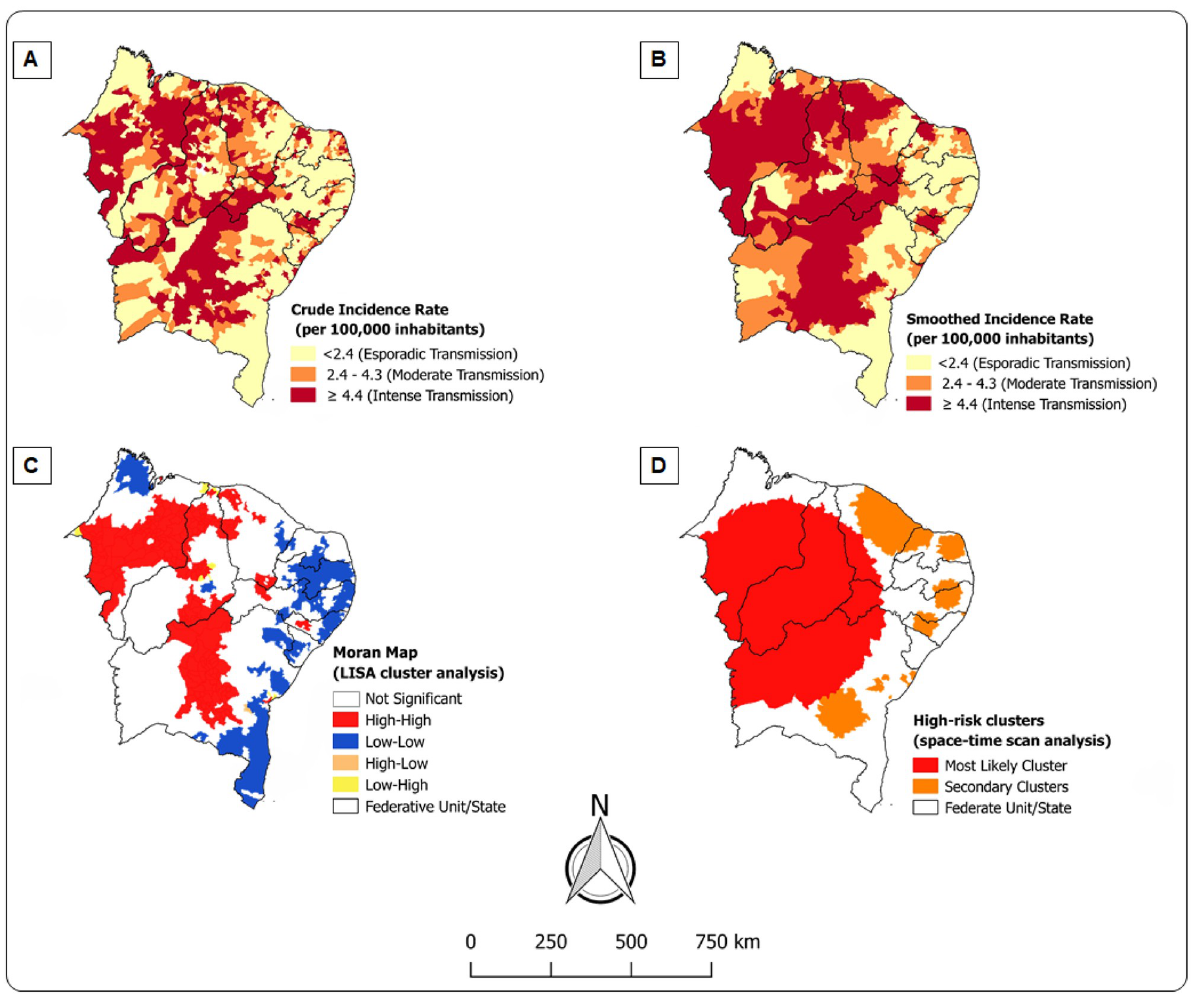
Fig 3. Spatial and spatiotemporal distribution of VL, Northeast, Brazil (2000–2017). The maps show high-risk clusters for VL transmission mainly in sertão and meio-norte sub-regions. (A) VL crude incidence rates. (B) VL smoothed incidence rates. (C) Univariate LISA cluster analysis. (D) Space-time scan statistical